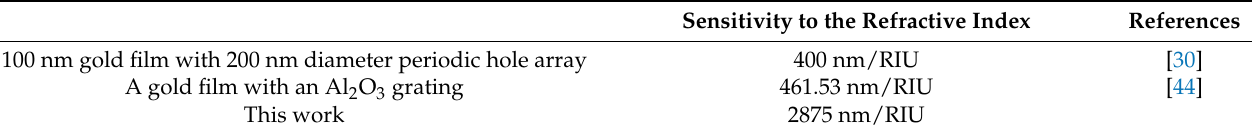
Table 5. Performance comparison of the different SPR sensors.